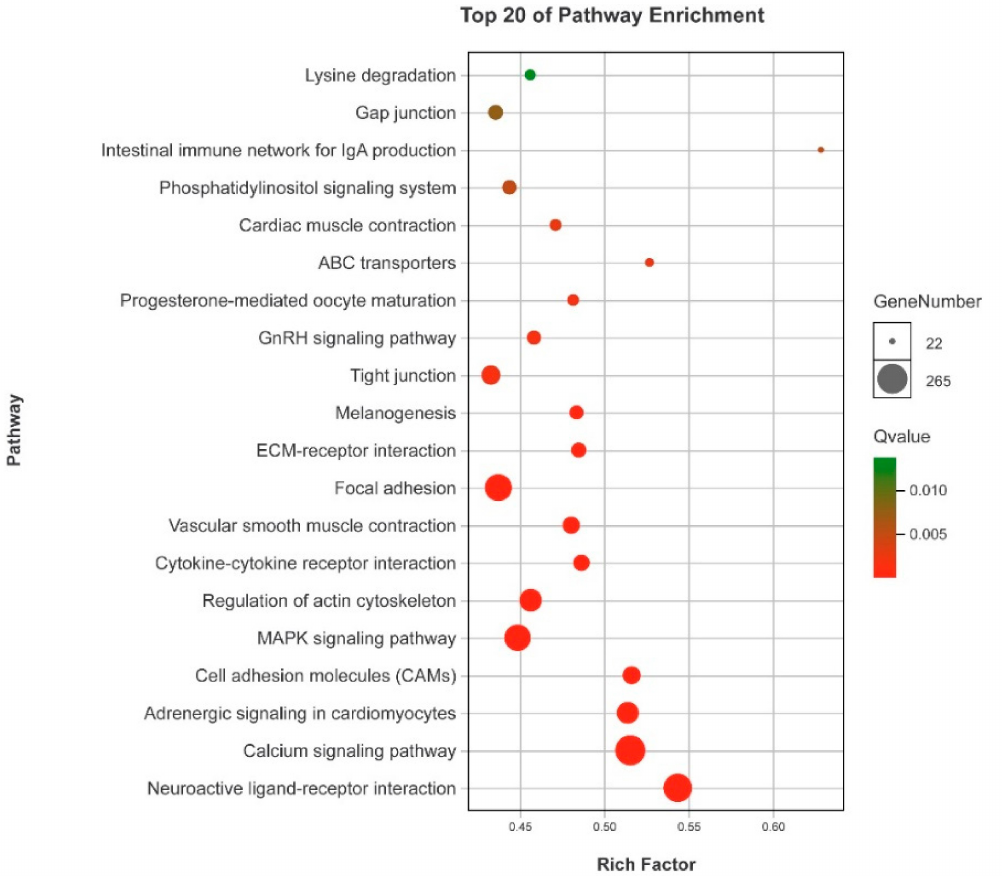
Figure 6. KEGG pathway enrichment analyses of